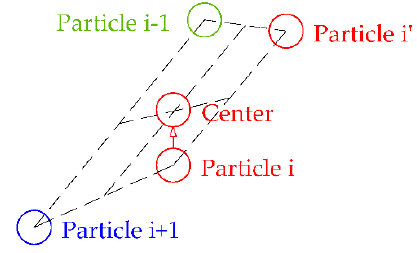
Figure 5. Graphical representation of location updating.